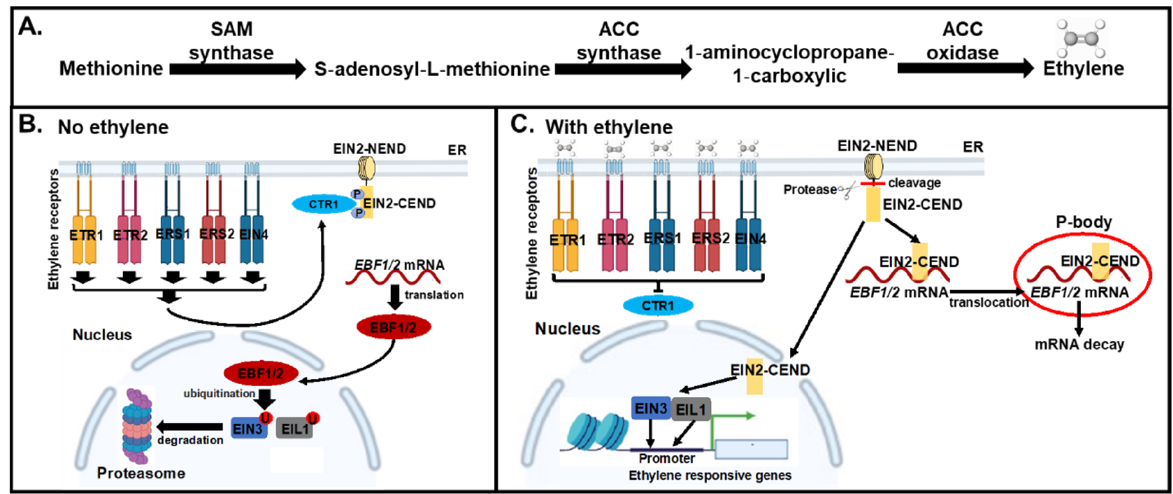
Figure 1. Schematic overview of ethylene biosynthesis and signaling in Arabidopsis. ( A ) Ethylene biosynthetic pathway. Amino acid methionine is converted into hormone ethylene by three families of enzymes, SAM synthetases that produce S-adenosyl-methionine out of methionine, ACC synthases that make 1-aminocyclopropane-1-carboxylic acid, and ACC oxidases that generate ethylene. Ethylene then diffuses out of and into plant cells. ( B ) Ethylene signaling pathway in the absence of ethylene. Ethylene receptors ETR1, ETR2, ERS1, ERS2, and EIN4 localized in the ER membrane activate CTR1 kinase, which in turn phosphorylates the C-terminal end of EIN2 (EIN2-CEND) and turns EIN2 off. The mRNAs for F-box proteins EBF1 and EBF2 are translated and target the master transcriptional regulators of ethylene signaling, EIN3 and EIL1, to proteasomes for protein turnover, thus preventing ethylene responses. ( C ) Ethylene signaling pathway in the presence of ethylene. Ethylene binding to the receptors shuts them off, CTR1 is inactivated, EIN2 is dephosphorylated and is cleaved by an unknown protease, thus releasing EIN2-CEND that functions in the cytoplasm and in the nucleus. In the cytosol, EIN2-CEND recruits EBF1 and EBF2 mRNAs to the P-bodies and inhibits their translation. In the nucleus, EIN2-CEND directly or indirectly potentiates the activity of EIN3 and EIL1. Ethylene-triggered stabilization of the EIN3/EIL1 transcription factors leads to the transcriptional regulation of multiple target genes, including induction of several members of the ERF gene family that encode transcription factors of the second tier of the ethylene response that propagate the EIN3/EIL1-triggered transcriptional programs. Positive interactions such as activation, production, and stabilization are represented with lines that end in an arrowhead → . Negative interactions such as inactivation and repression are represented by lines that end in a hammerhead ⊣ . Images were created with BioRender.